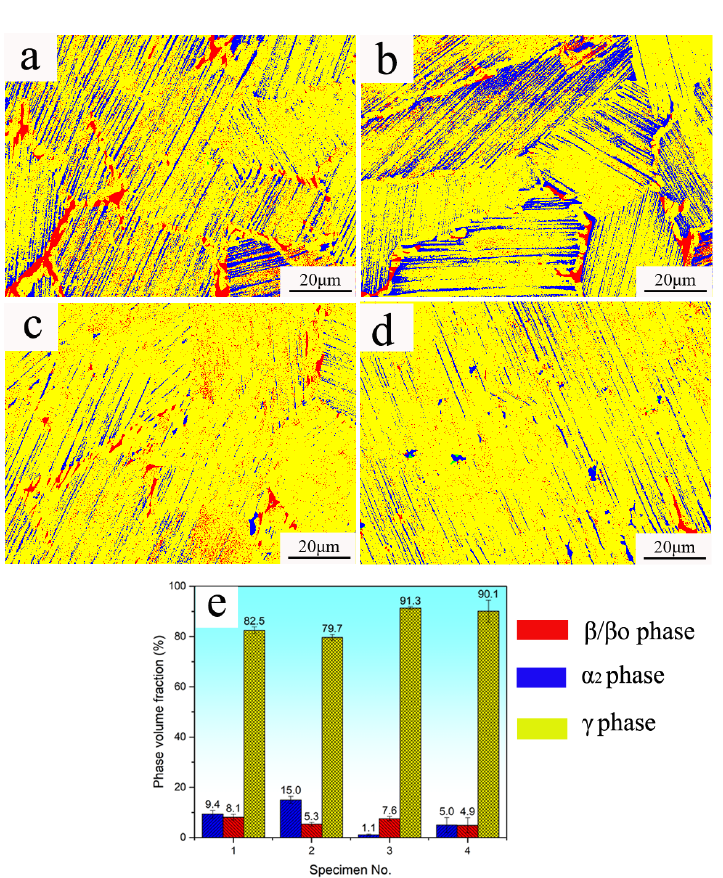
Figure 3. The EBSD phase distribution and statistics results of the volume fractions of different phases in the following alloys: ( a ) S1, ( b ) S2, ( c ) S3, ( d ) S4, ( e ) the statistical information from the EBSD data.